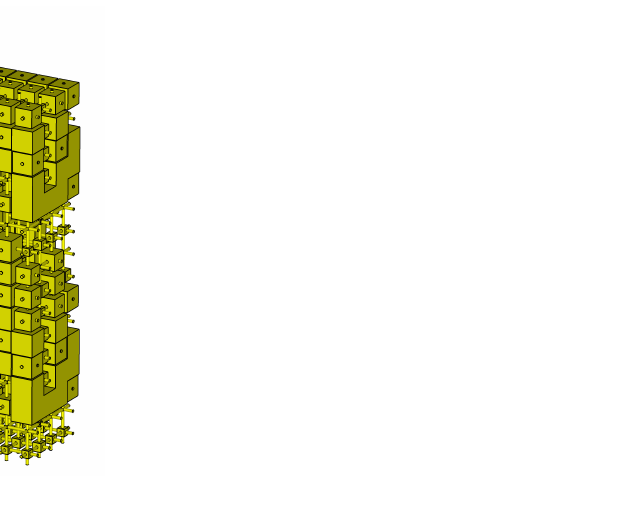
Figure 11. Designed BDS prototype with four-layer cube arrangement. ( a ) Top view, ( b ) bottom view,